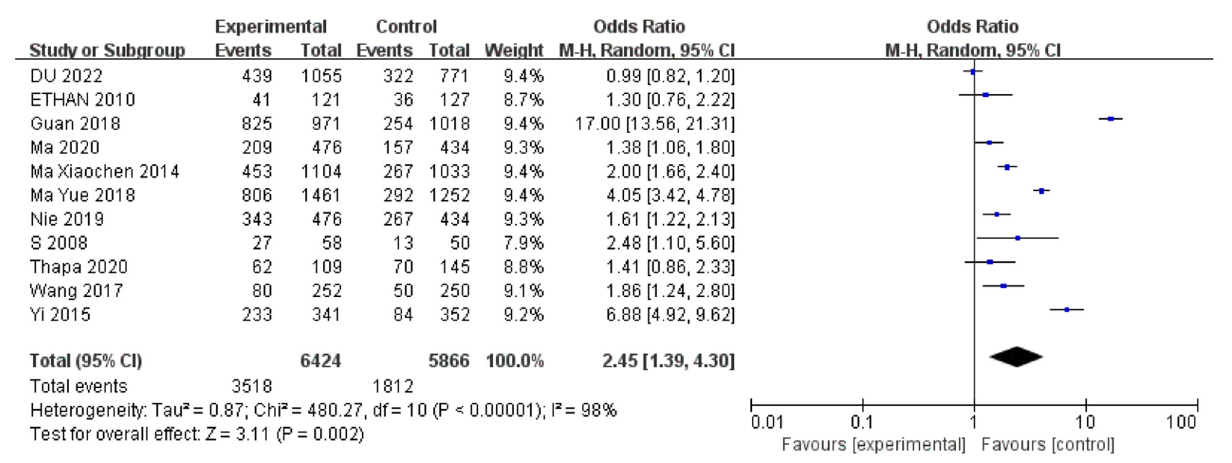
FIGURE2 Random-effect meta-analyses of the spectacle-wear compliance ( N = 11).